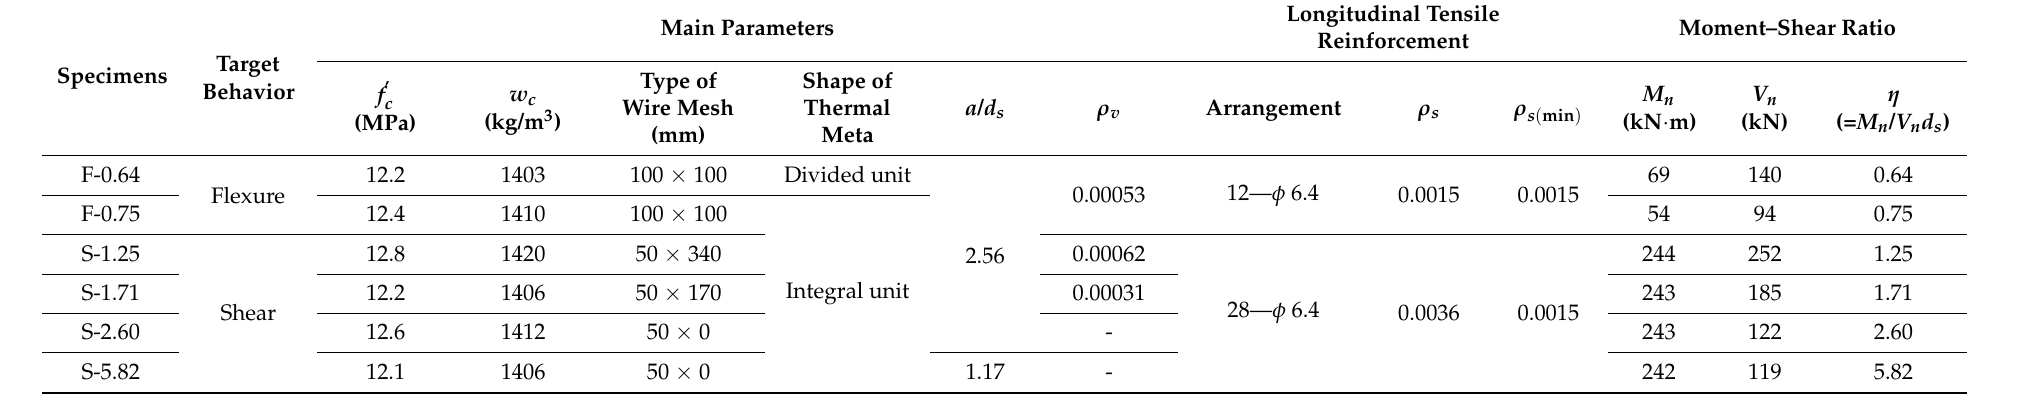
Table 3. Details of the insulation-panel